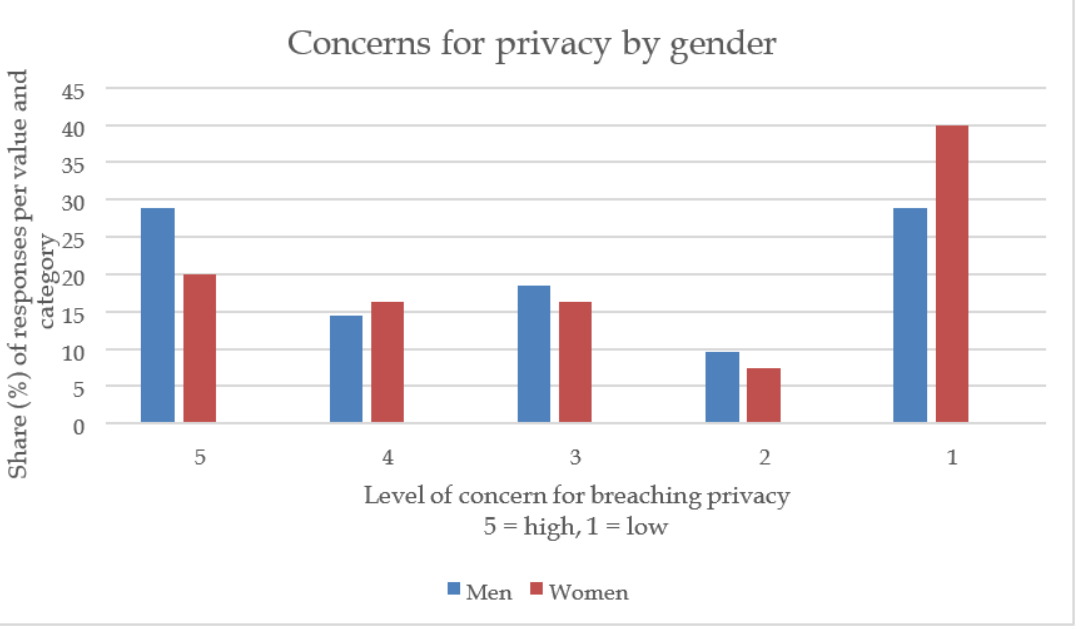
Figure 5. Concern about breaching privacy and gender, percentage per reported value on scale 5-1. Male n=146 (100%), Female n=135 (100%), Total n=281.